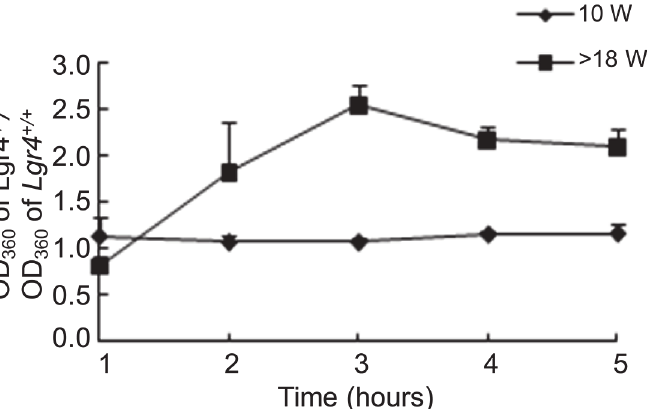
to oxidative damage with 0.1 mM H 2 O 2 and 2.31 units of glucose oxidase (GO) for indicated times. Sample absorbance was measured at 360 nM. Supernatants from Lgr4 knockout lenses showed a more rapid increase in turbidity (and therefore, protein denaturation), suggesting that the knockout lens had less overall resistance to oxidation than wild-type. Data are expressed as mean ± SD (n = 3). These results are representative of 3 independent experiments.